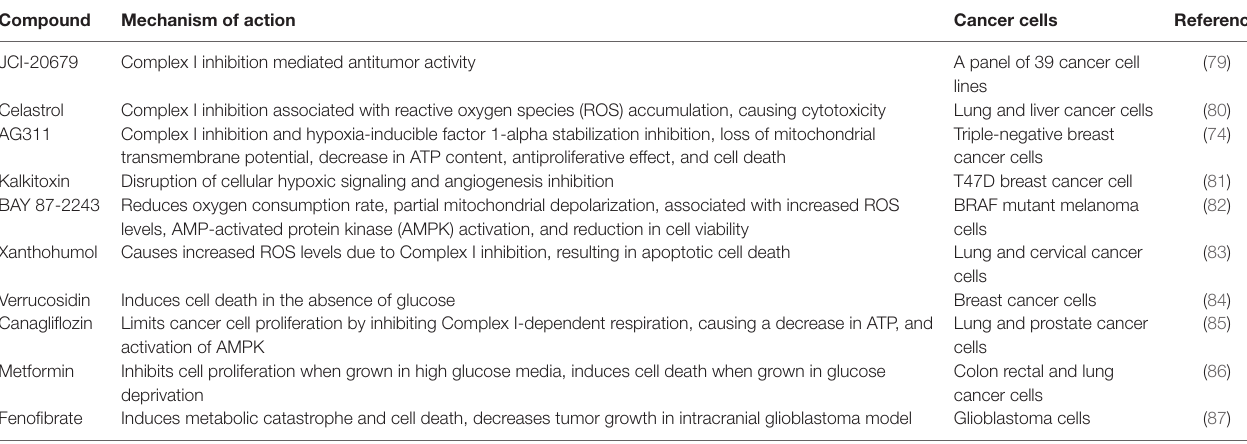
TABLe 1 | New small molecules and Food and Drug Administration-approved drugs reported as Complex I inhibitors with anticancer